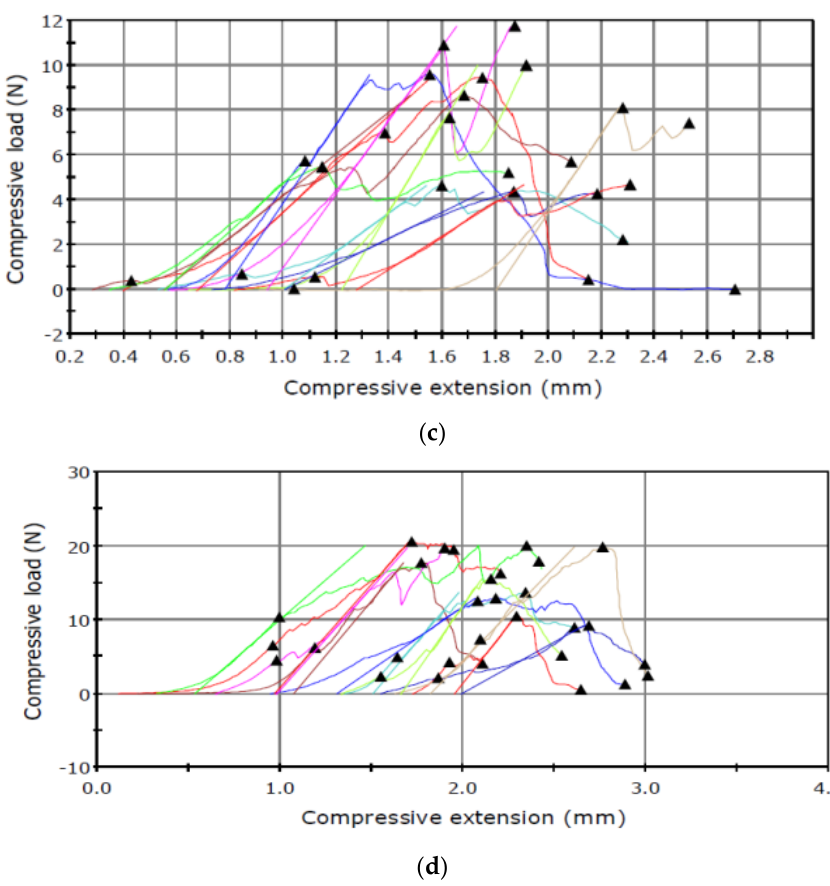
Figure 2. Puncture test carried out in June for the seed capsule of ( a ) I. aphylla and ( b ) I. sibirica and for the seeds of ( c ) I. aphylla and ( d ) I. sibirica .